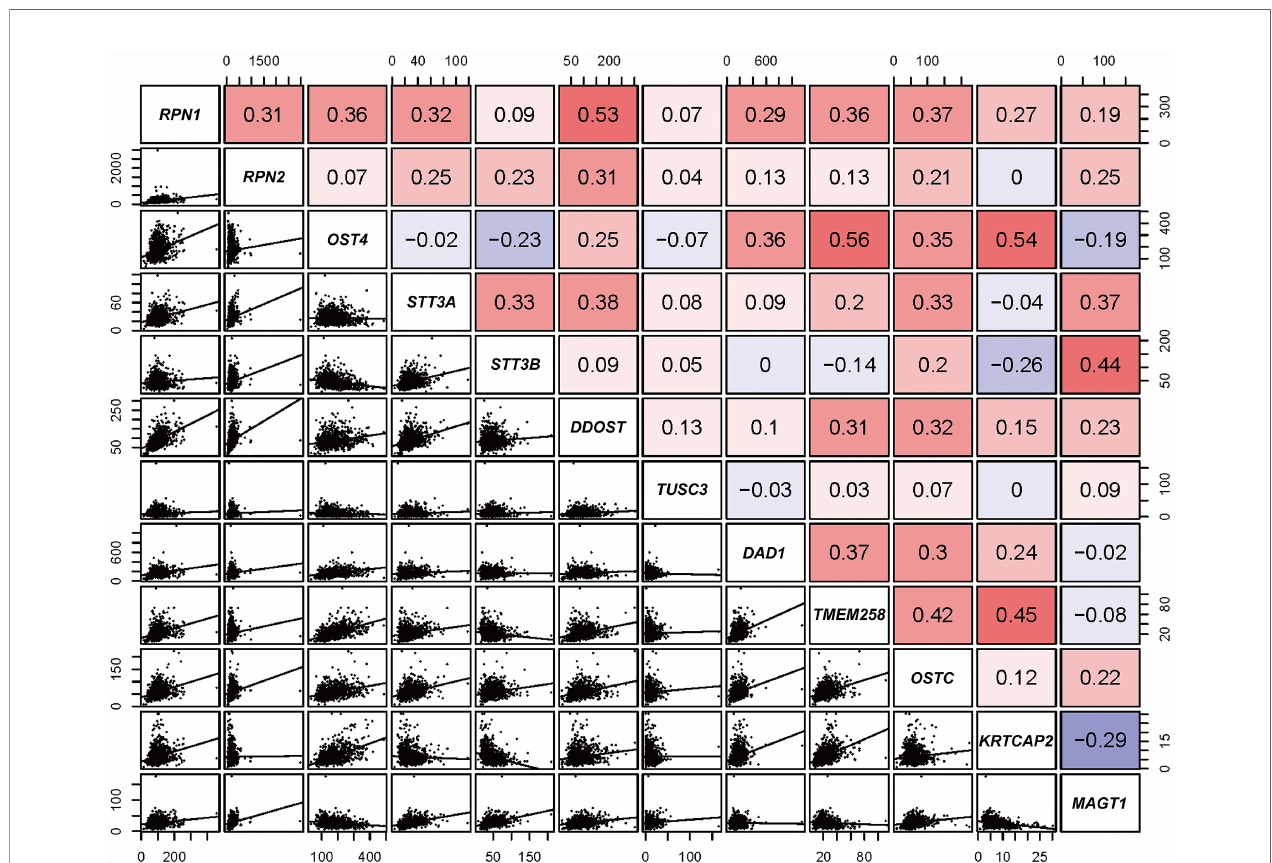
FIGURE 1 | Correlation analysis of OST family members (data from TCGA). Pearson ’ s correlation of OST subunits. In the upper right, red and blue cells represent positive and negative relationship, respectively. In the lower left, correlation scatter diagram of the two genes is